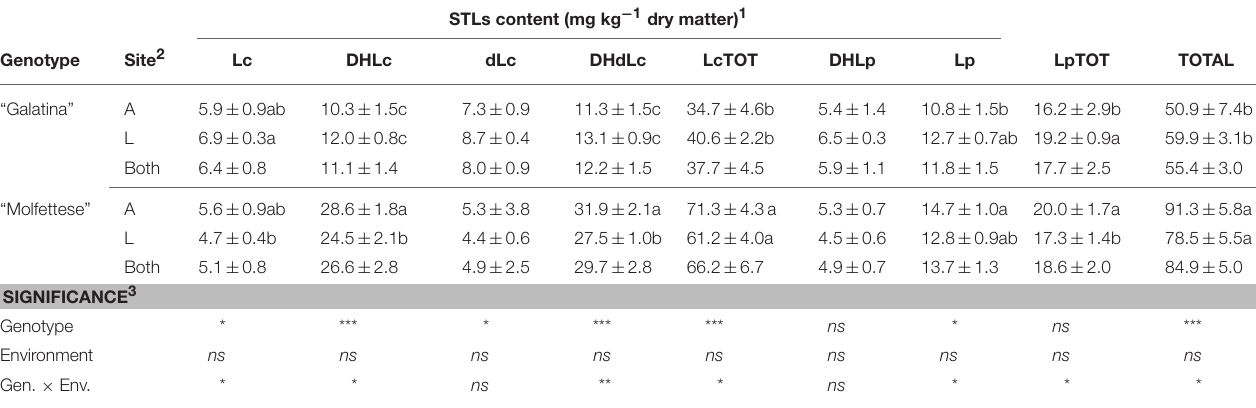
TABLE 1 | The sesquiterpene lactone (STL) content in stems of “Galatina” and “Molfettese”